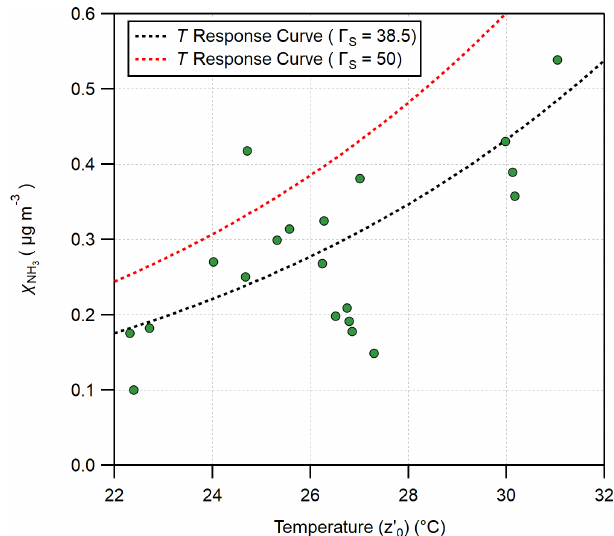
Figure 4. Estimating the stomatal compensation point from the am- bient NH 3 concentrations at which the flux changed signs as a func- tion of the temperature at z (cid:48) . The black dotted line shows the tem- 0 perature response curve calculated using an apoplastic ratio of 38.5, while the red dotted line shows the temperature response curve cal- culated using a ratio of